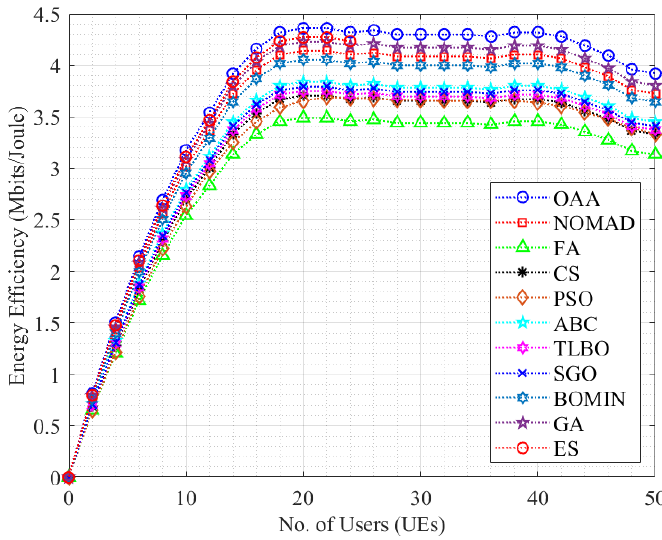
Figure 12. Average EE of network with OAA and other algorithms.